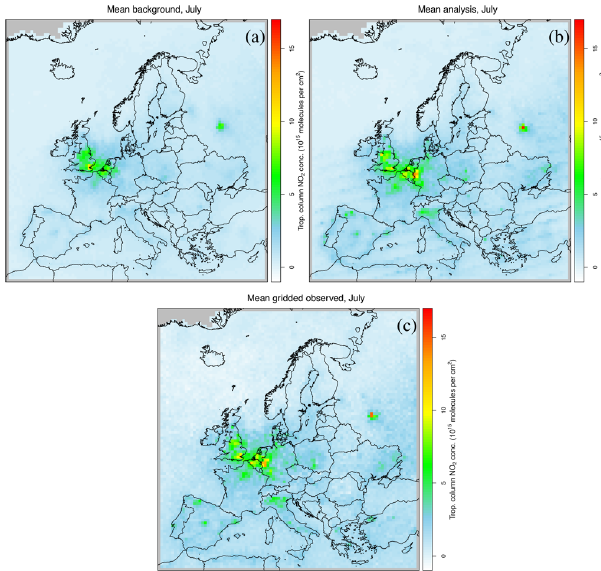
Fig. 13. Tropospheric column concentration averaged over all as- similation cycles for a month. (a) and (b) show grid-averaged fields of H x b and H x a , respectively, for Exp. 2. (c) presents the grid- averaged OMI retrievals. Grid cells with no observations are shown in grey. Only observations passing the quality-control criteria de- scribed in Sect. 2.1 were considered, and this is reflected in the grey areas